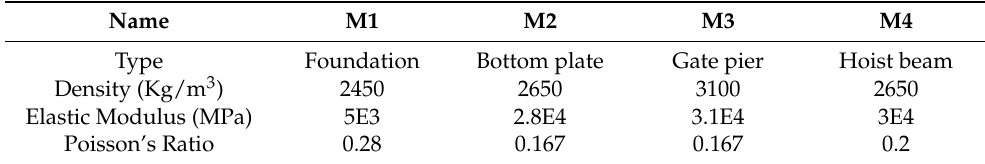
Table 1. Material parameters of the sluice system.